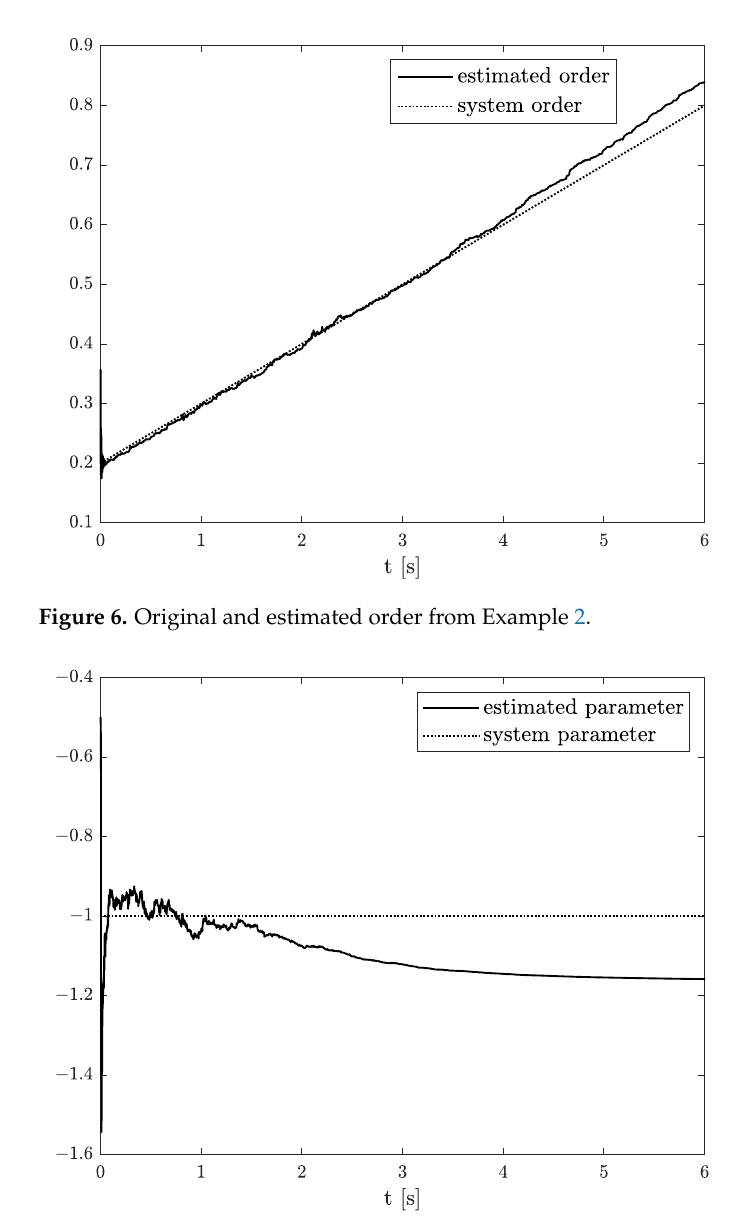
Figure 7. Original and estimated parameter from Example